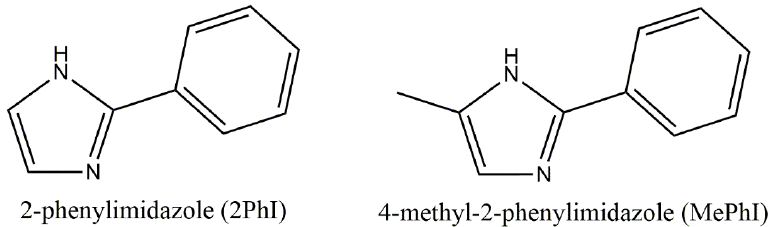
Figure 1. The structure of the corrosion inhibitor tested (2PhI) compared with MePhI.